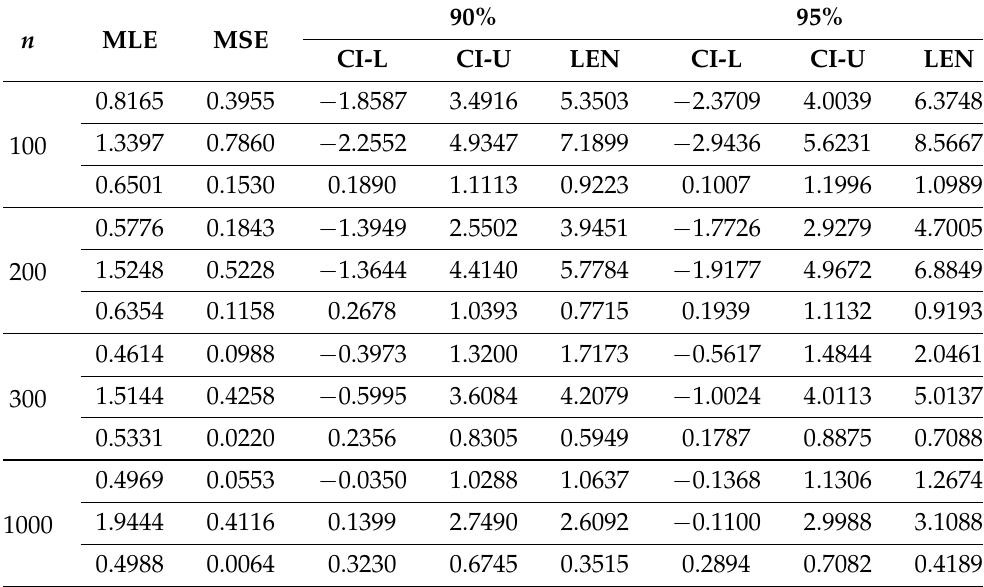
Table 5. Numerical values of the MLEs, MSEs, CI-Ls, CI-Us, and LENs for the parameters of the UG/G model for Config4.